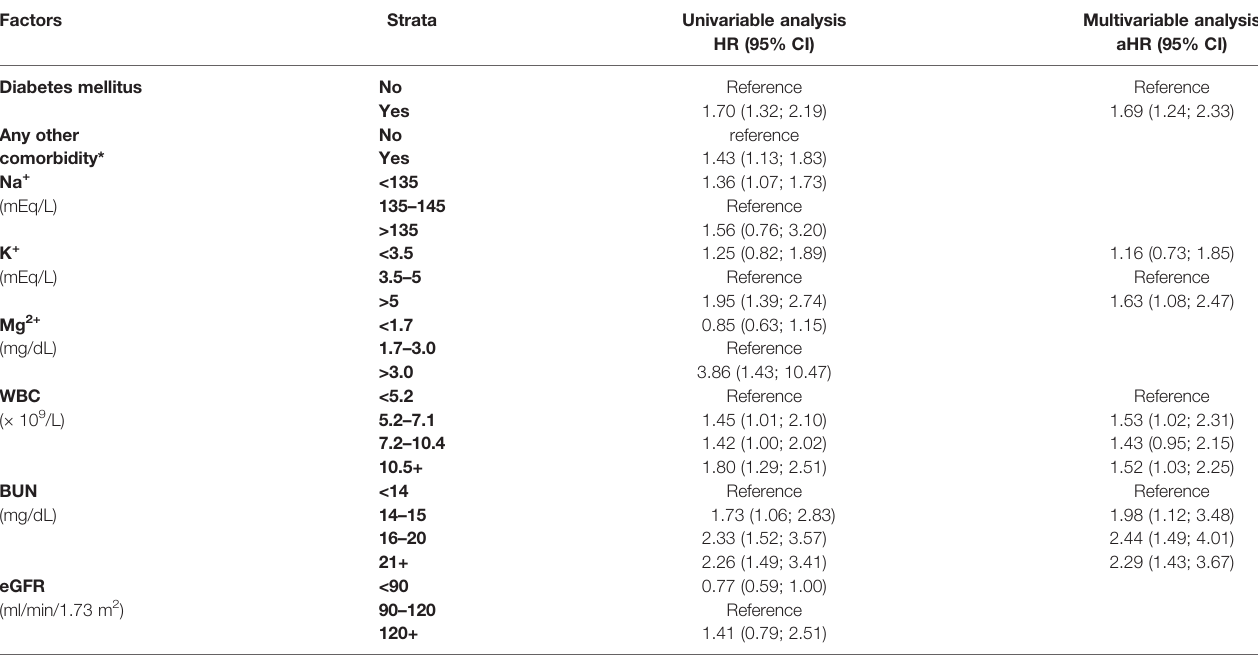
TABLE 4 | Multiple Cox regression model on the risk of acute kidney injuries